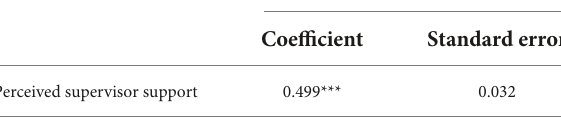
TABLE 4 Standardized results of the main effects of the Perceived supervisor support.